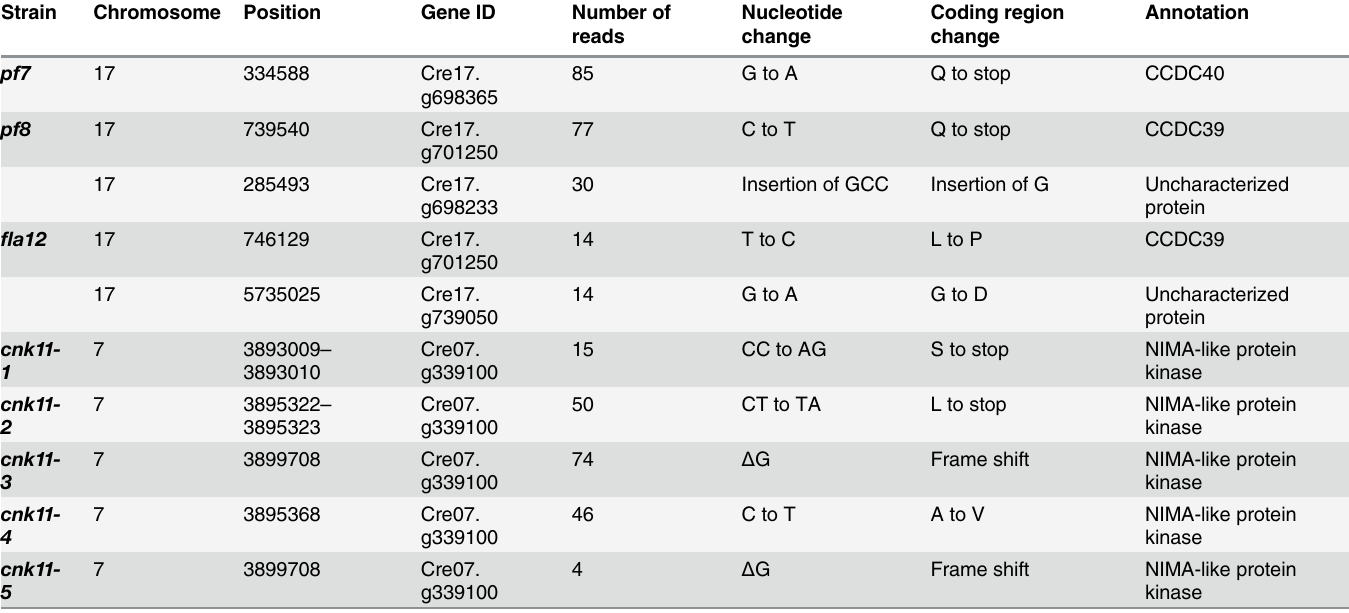
Table 2. Sequence changes found in individual mutant strains.